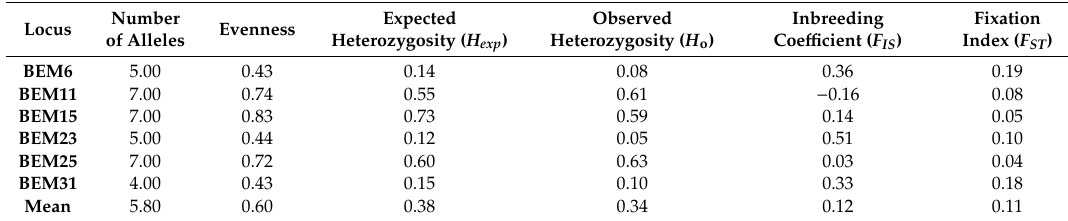
Observed Heterozygosity ( H o )